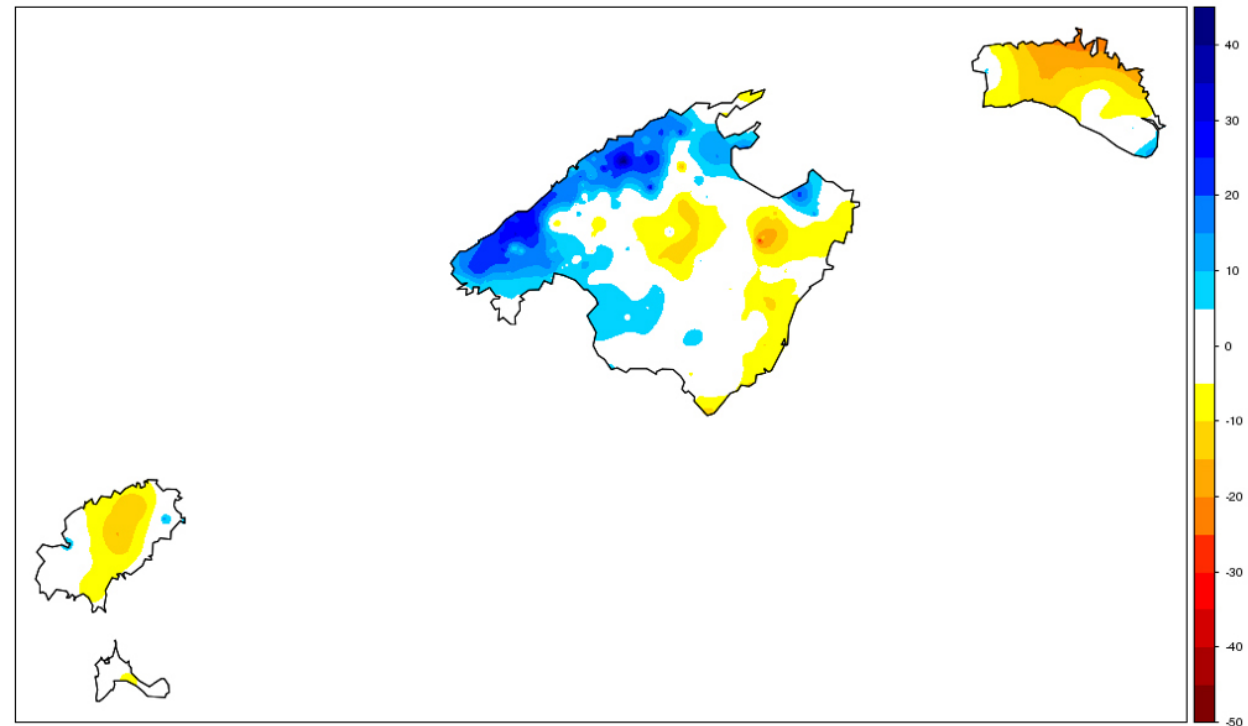
Figure 11. Trend of the seasonal precipitation (mmdecade − 1 ) for autumns in the period